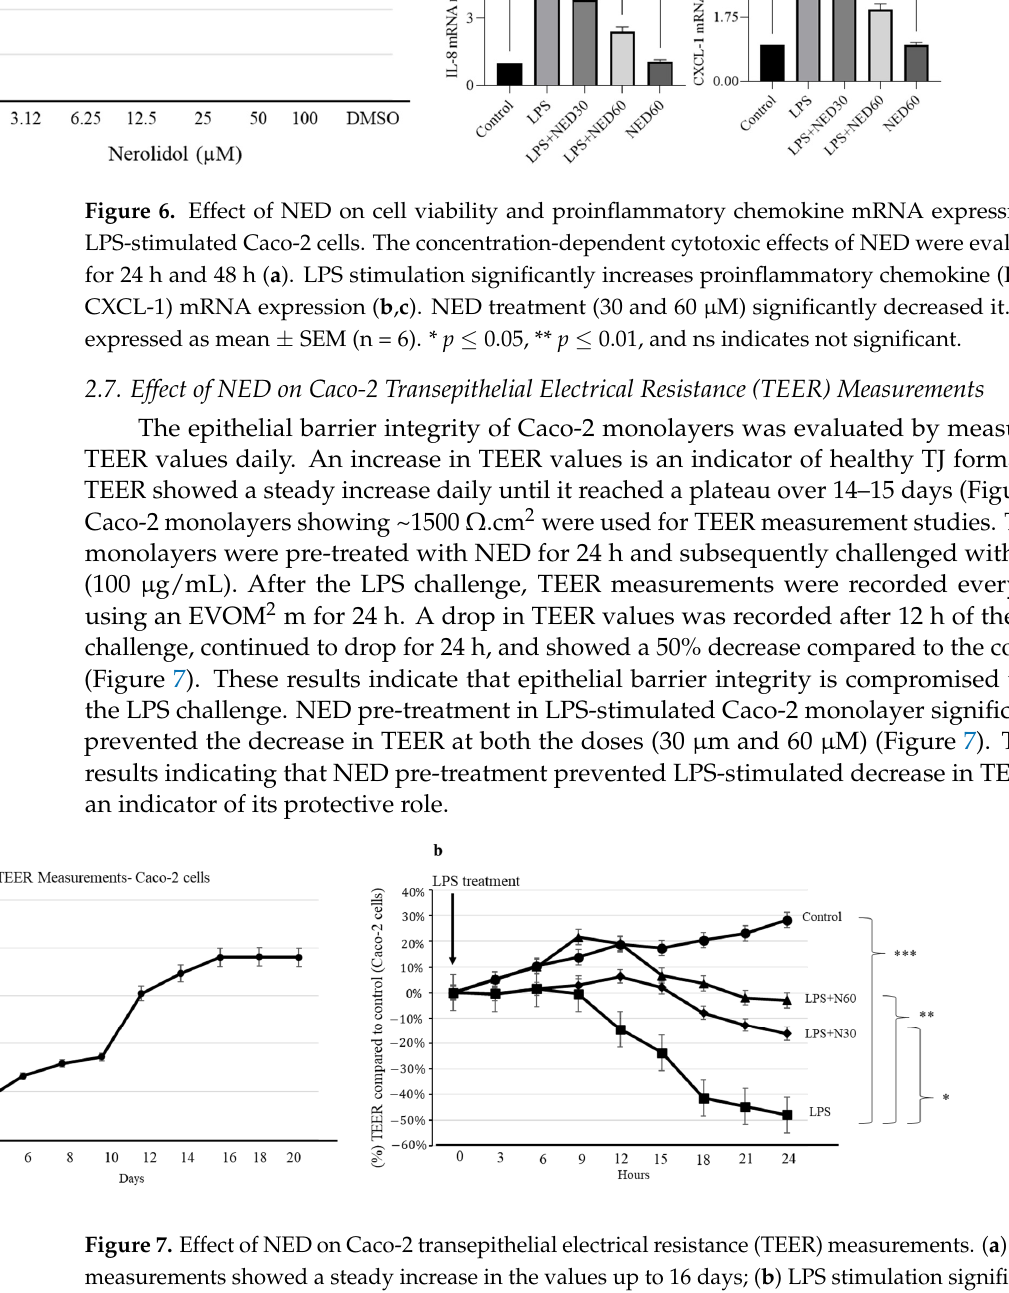
Figure 7. E ff ect of NED on Caco-2 transepithelial electrical resistance (TEER) measurements. ( a ) TEER measurements showed a steady increase in the values up to 16 days; ( b ) LPS stimulation sig- ni fi cantly reduced the TEER measurements. Preincubation with NED signi fi cantly prevented fur- ther drop in TEER values. Data are expressed as mean ± SEM (n = 6). *** p ≤ 0.001, ** p ≤ 0.01, * p ≤ 0.05, and ns = not signi fi cant.